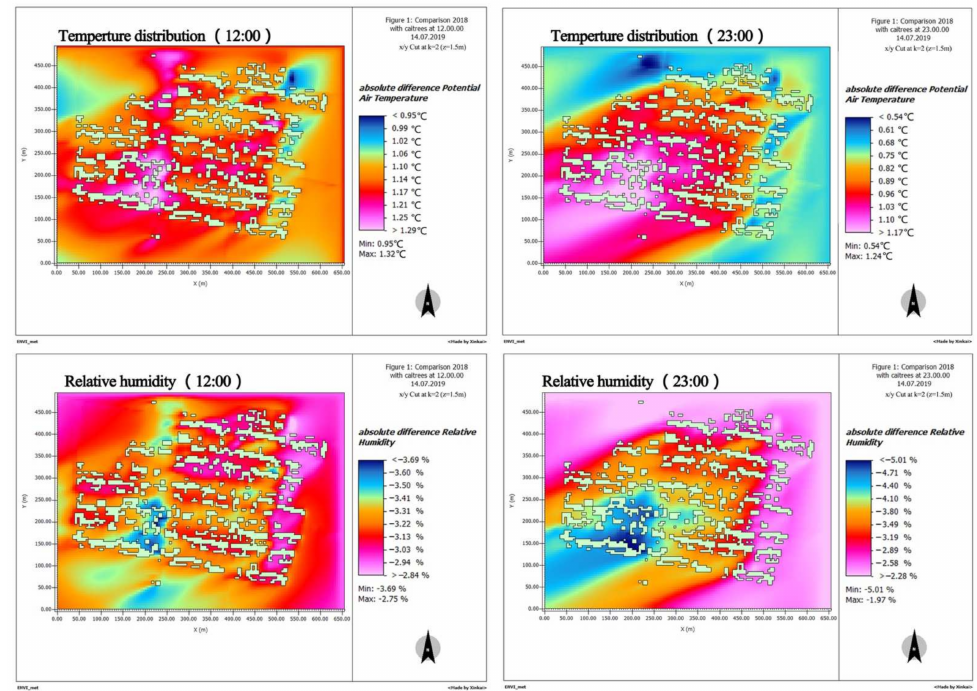
Figure 9. Difference values distribution maps of air temperature (AT) and relative humidity (RH) at 1.5 m from the ground at daytime (12:00) and nighttime